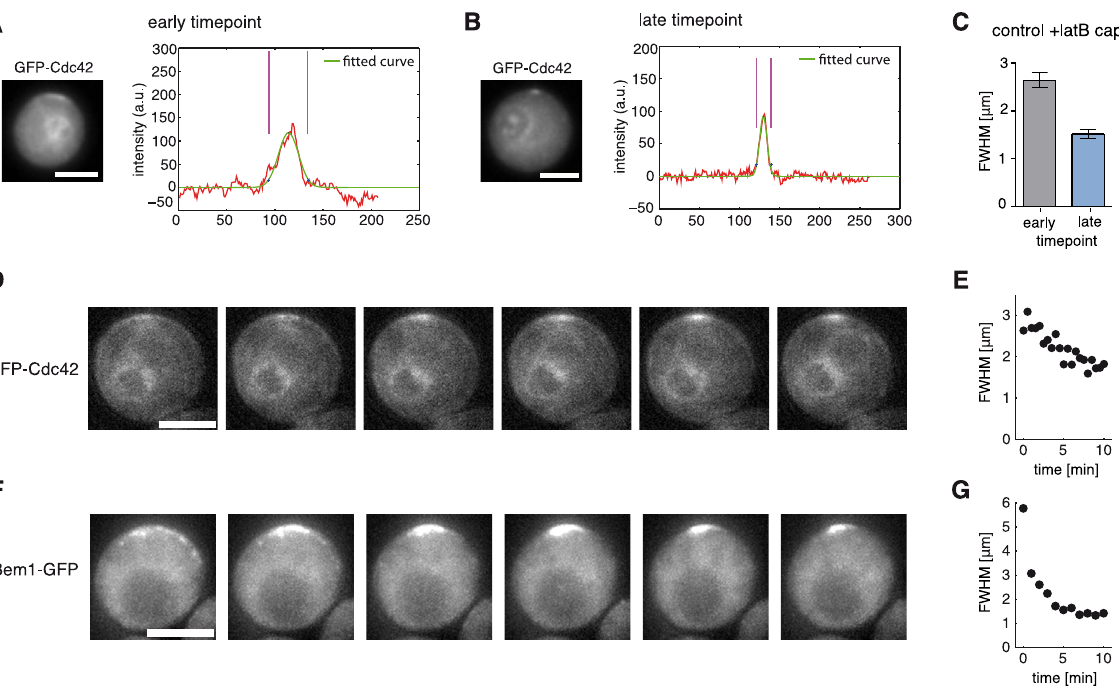
Figure 3. Experimental characterization of GDI-mediated polarization. A,B Representative images and cap intensity profiles of latrunculin B-treated control cells expressing GFP-Cdc42 at an early (20–30 min after release, A) and late (30–50 min after release, B) time point during polarization. C Comparison of full width at half maximum (FWHM) of GFP-Cdc42 + latrunculin B caps at early (N=13, SEM=0.15; 20–30 min after release) and late time points (N=28, SEM=0.10; 30–50 min after release), unpaired t-test with Welch correction, p , 0.001. D Time series showing GFP-Cdc42 cap establishment in a control cell treated with latrunculin B (Movie S2, every second frame starting from frame 12, 30 s time steps between frames). E Time evolution of full width at half maximum of GFP-Cdc42 cap shown in (D) and Movie S2 (first width corresponds to frame 10 of Movie S2). F Time series showing Bem1-GFP cap establishment in a control cell treated with latrunculin B (Movie S3, every frame starting from frame 8, 60 s time steps between frames). G Time evolution of full width at half maximum of Bem1-GFP cap shown in (F) and Movie S3 (first width corresponds to frame 8 of Movie S3). Scale bars: 4 m m.